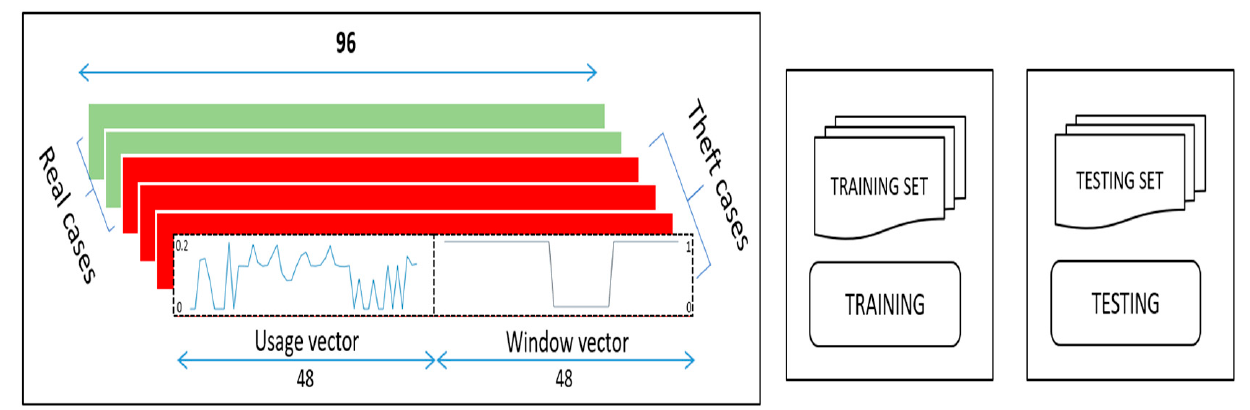
Figure 4. Novel concatenation data processing in the DETD algorithm.